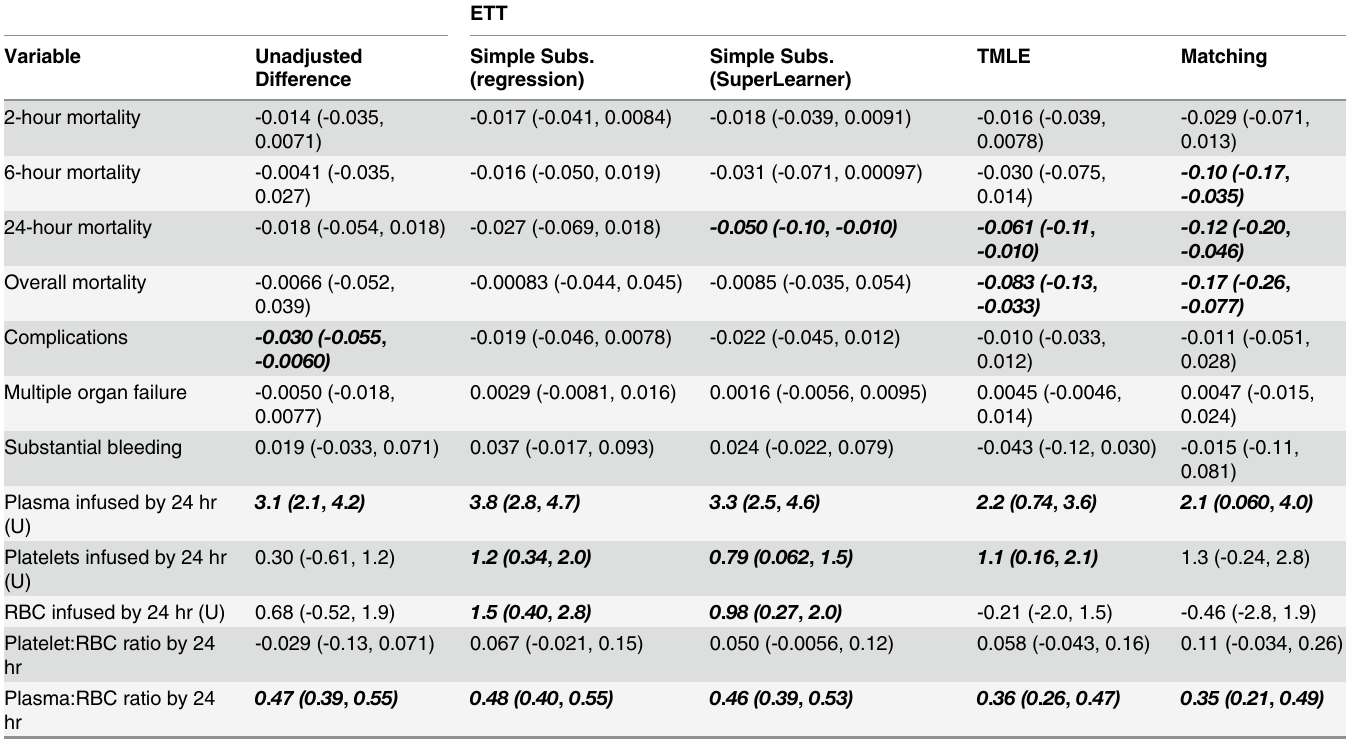
Table 2. Difference in means, and adjusted ETT estimates (simple substitution, TMLE, and propensity score matching). 95% confidence intervals are included in parentheses after each estimate. Asymptotic (normal-based) confidence intervals were calculated using the standard error of the Unadjusted, Targeted Maximum-Likelihood, and Matching estimators. The nonparametric bootstrap was used to generate 95% confidence intervals in the case of the Simple Substitution